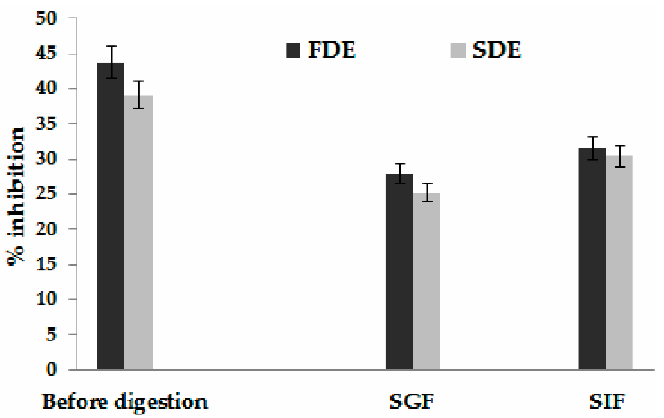
Figure 1. The potential of freeze-dried encapsulates (FDE) and spray-dried encapsulates (SDE)to inhibit α -glucosidase before and during simulated gastric (SGF) and intestinal fluids (SIF).